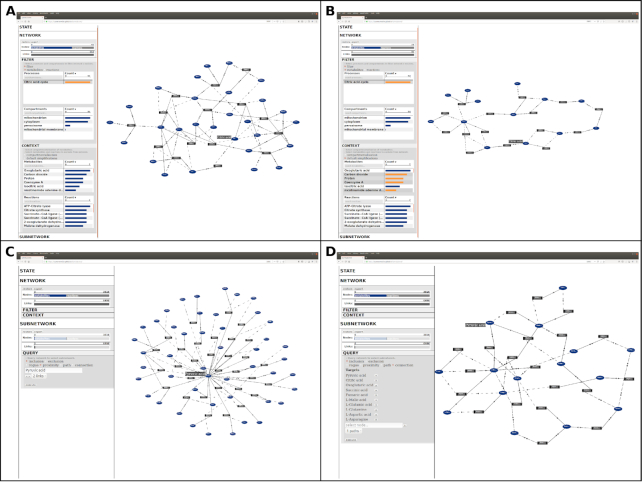
Screen images from DyMetaboNet web application. DyMetaboNet is a web application that defines and visualizes custom metabolic networks within the internet browser. A, With hubs, the citric acid cycle has dense connectivity that obscures its cyclical structure. B, Exclusion of hubs coenzyme A, carbon dioxide, proton, and nicotinamide adenine dinucleotide (NAD1+) reveals the overall cyclical structure of the citric acid cycle. C, Queries by proximity (breadth-first search) include nodes within a specific range of links to a focal node. For example, the user might need to know all reactions in which pyruvate participates. D, Connection queries (pairwise simple shortest paths) allow construction of subnetworks between multiple metabolites of interest. For example, the user might need to know how pyruvate, citrate, oxoglutarate, succinate, fumarate, malate, gutamate, glutamine, aspartate, and asparagine relate to each other. This project’s data archive [15] includes a screen-capture video of DyMetaboNet that demonstrates these features and more.